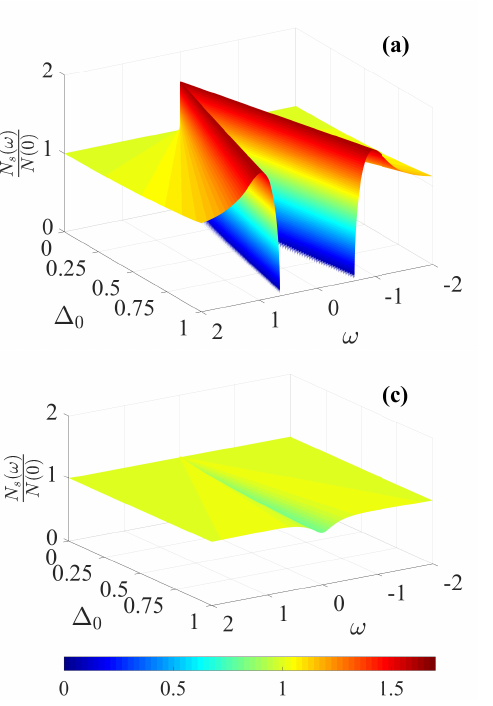
Figure 2: Evolution of the DOS in the ω - ∆ through the collapse of the energy gap ζ = 1 (b), to the gapless state with ζ = 1.75 (c). Arbitrary units for ω and ∆